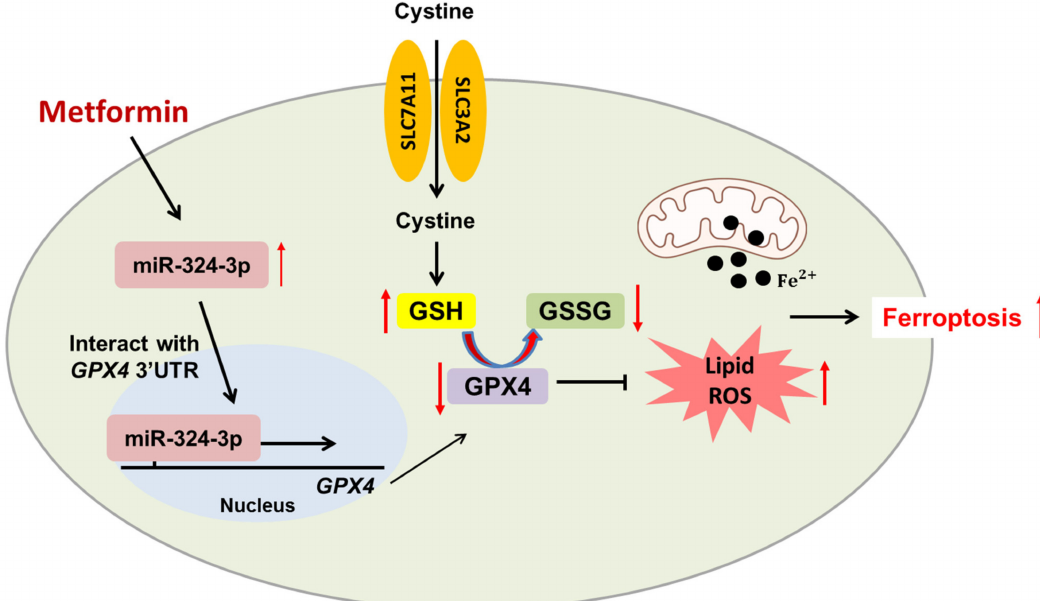
Figure 5. Metformin triggers ferroptosis. Metformin downregulates GPX4 by upregulating miR-324-3p; this contributes to the increased accumulation of lipid ROS and further promotes